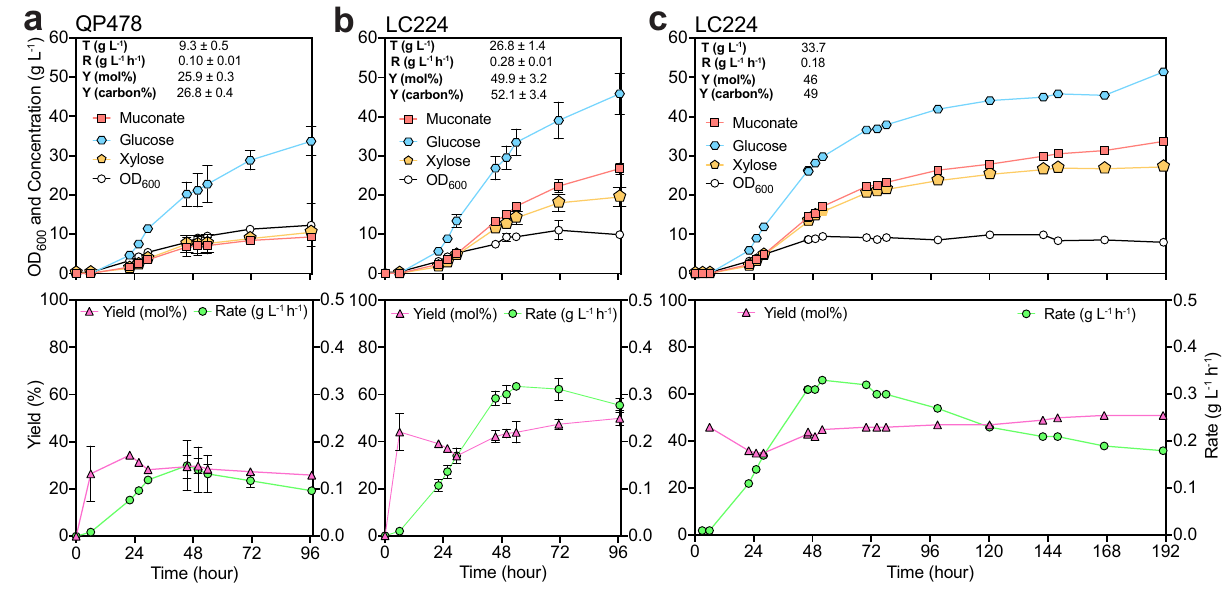
Fig. 5 | Bioreactor pro fi les from strains QP478 and LC224 in fed-batch mode. a , b Bacterialgrowth,glucoseandxyloseutilization,andmuconatetiters,yields,and rates from QP478 and LC224 in 96.6-h cultivations. c Bacterial growth, glucose and xylose utilization, and muconate titer, yields, and rate from LC224 in 191-h cultiva- tion. For a and b , data points represent the average values of biological duplicates, error bars represent the absolute difference between the data generated from duplicates at each time point; for ( c ), data points represent the values of singlets. Metabolic yields (mol%) at each time point were calculated as the amount of